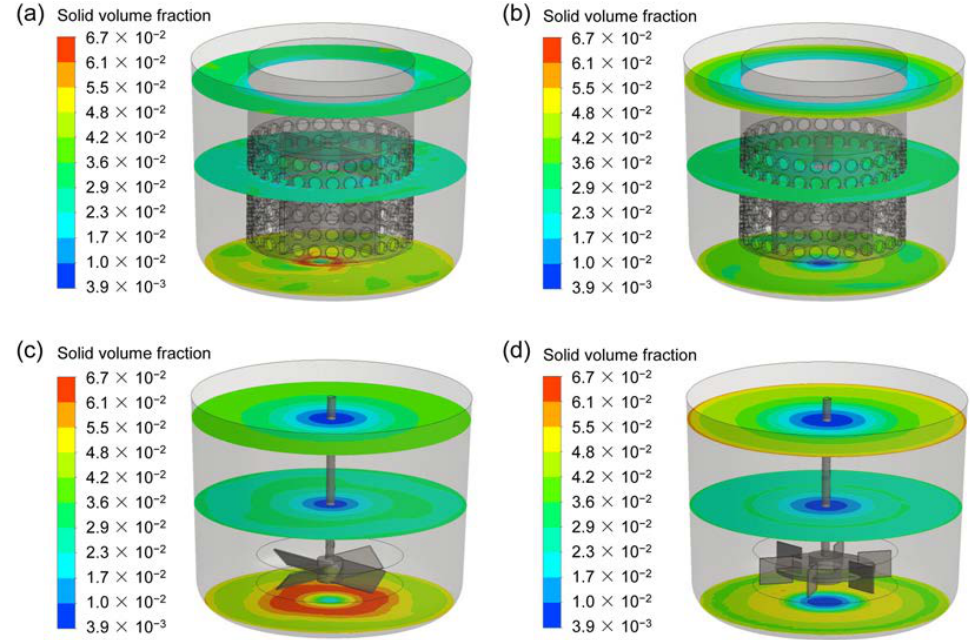
Figure 11. The distribution of solid volume fraction at the vertical plane for the four types of agita- tors at the stirring speed of 400 rpm; ( a ) CSRS agitator; ( b ) HCSRS agitator; ( c ) A200 agitator; ( d ) Rushton agitator.